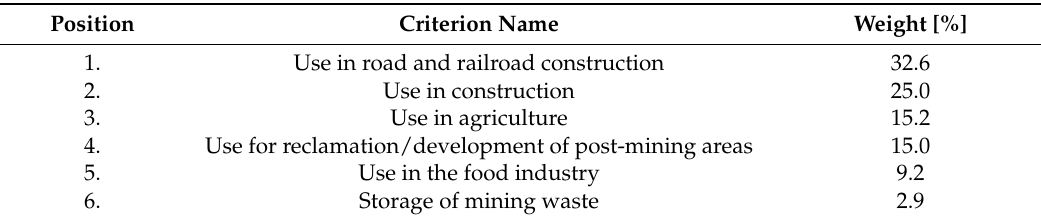
Table 2. Weights of criteria (potential waste uses).